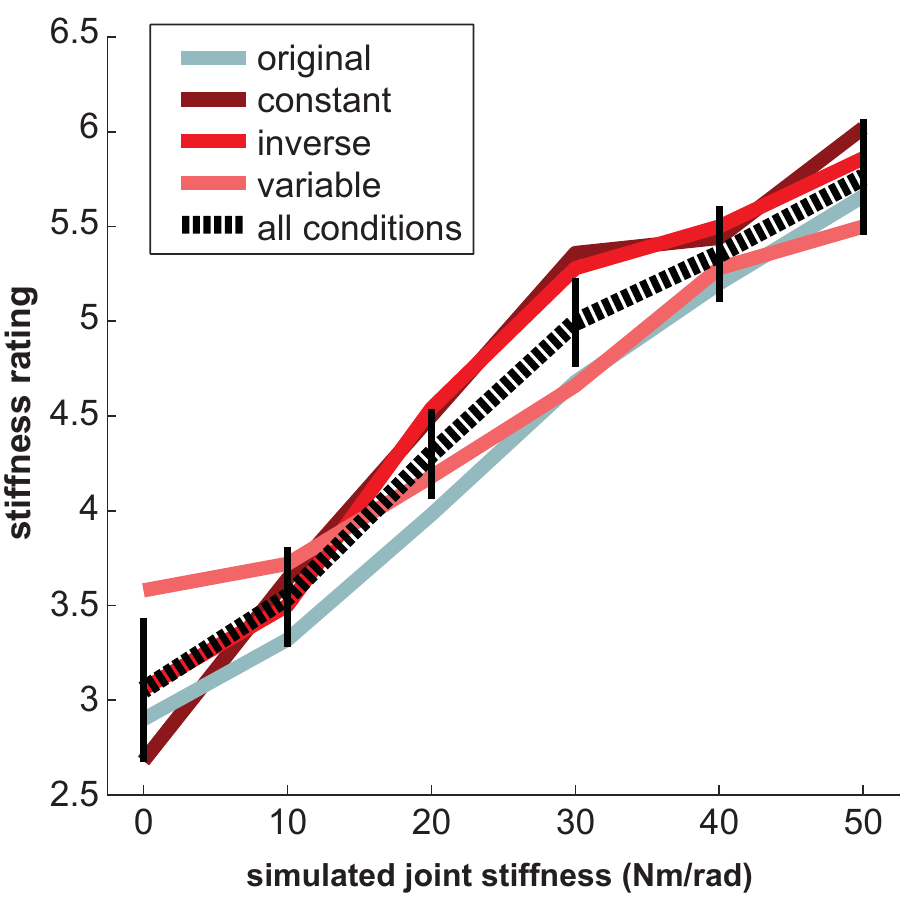
Fig 5. Experiment 1 stiffness estimate results. In all four experimental conditions, there was a significant positive effect of joint stiffness on the arm stiffness estimates. Solid lines show the average arm stiffness estimate across subjects within each condition. The dashed line shows the average stiffness estimate across subjects in all conditions. Error bars represent ± 2 standard errors of the mean.